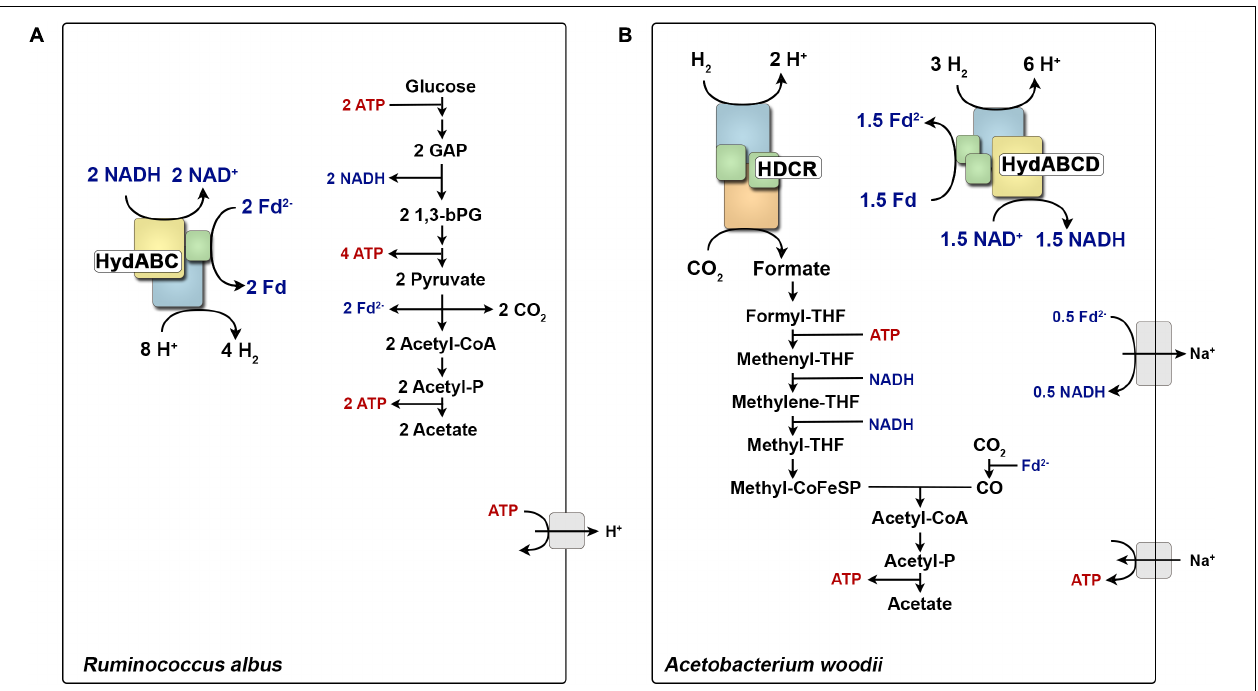
FIGURE 1 | Role of multimeric hydrogenases in the energy metabolism of Ruminococcus albus (A) and Acetobacterium woodii (B) . During glucose fermentation, R. albus oxidizes glucose to two molecules acetate. All generated reducing equivalents are reoxidized by the electron confurcating hydrogenase HydABC. In contrast, A. woodii can grow with H 2 + CO 2 as substrates and forms acetate as major end product. HDCR catalyzes the first step of the WLP from CO 2 to formate. All reducing equivalents are provided from H 2 oxidation catalyzed by the electron bifurcating hydrogenase HydABCD. Fd 2 - , reduced ferredoxin; CoA,